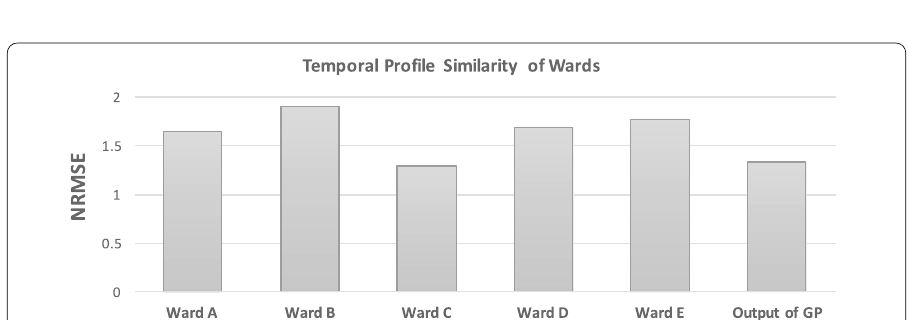
Figure 6 Stable temporal profiles. Top panel: the normalized stable temporal profile of the new venue with the profile of similar wards. Bottom panel: the output of the GP trained on the similar ward profiles; this serves as a prediction of the profile of the new venue